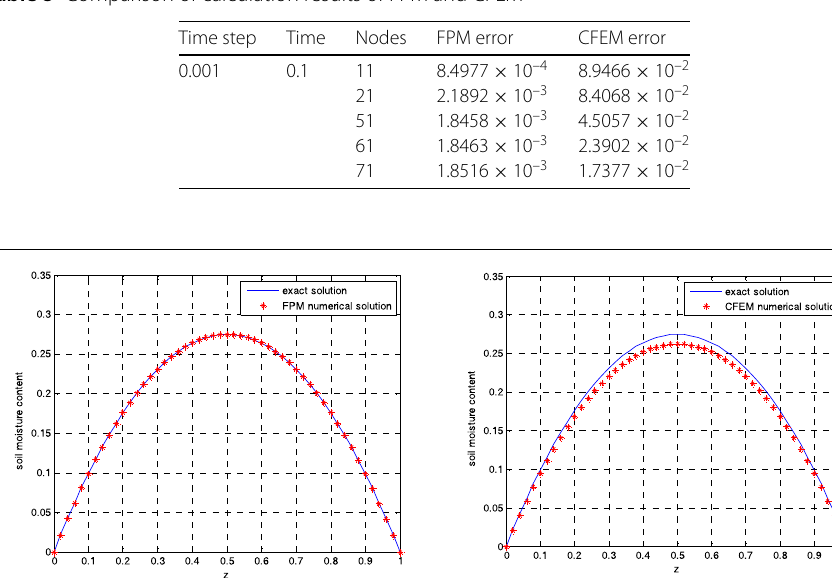
Table 8 Comparison of calculation results of FPM and CFEM